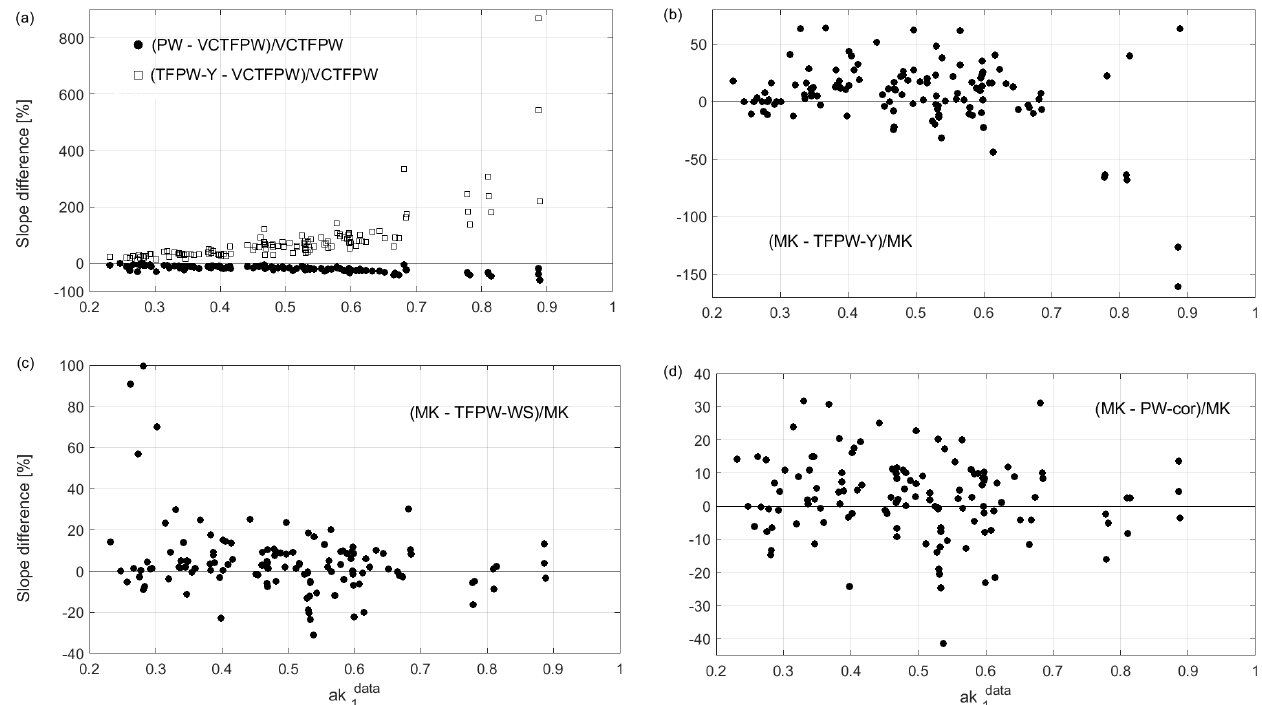
Figure 4. Slope differences as a function of ak data from the original data for all data sets, granularities and periods and for meteorological 1 season time segmentation: (a) PW minus VCTFPW slope (filled dots) and TFPW-Y minus VCTFPW slope (open squares) normalized by the VCTFPW slope, (b) MK slope minus TFPW-Y slopes, (c) MK minus TFPW-WS slopes and (d) MK minus PW-cor slopes. The slope differences in (b, c, d) are normalized by MK slope. Not ss trends (PW taken as reference) are not plotted since the slopes cannot be distinguished from the zero trend. Note the different y axis ranges in these plots.